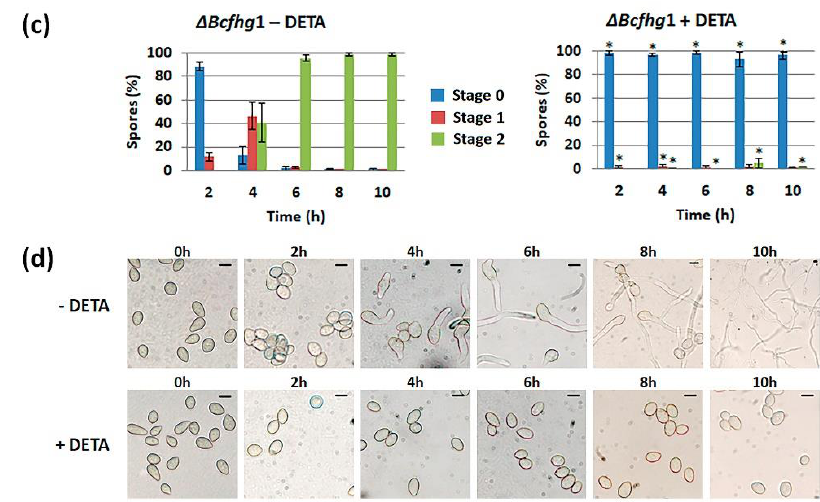
Figure 2. Germination kinetics of B. cinerea B05.10 ( a ) and Δ Bcfhg 1 ( c ) spores cultured in PDB ½ medium under static culture conditions. Germination was evaluated by quantifying the number of spores in stages 0, 1 or 2 at the indicated time points. The graphs show the means of three replicates ± SD ( n > 100 each). (* indicates significant differences at p < 0.05—Student’s t -test—in the presence of 250 μM DETA and its reference situation in the absence of DETA.) ( b – d ) Representative images of the germination process of each strain at the time points considered. Scale bars, 10 μm.